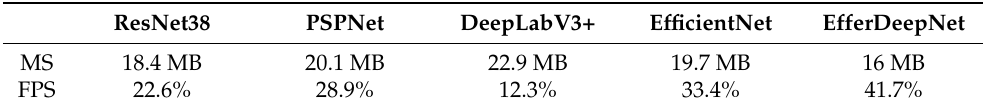
Table 5. Real-time performance comparison between the EfferDeepNet network and other networks on the Cityscapes dataset.